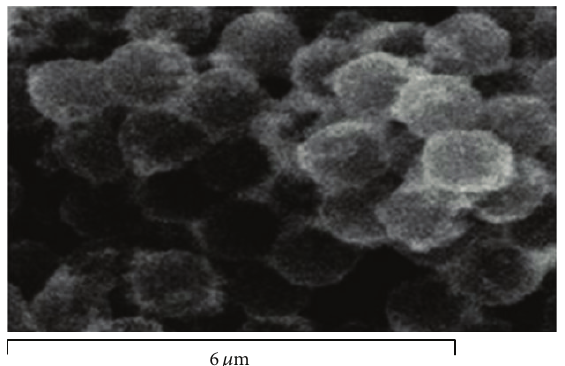
Figure 5: Scanning electron microscopy image of polystyrene/Ag microspheres.